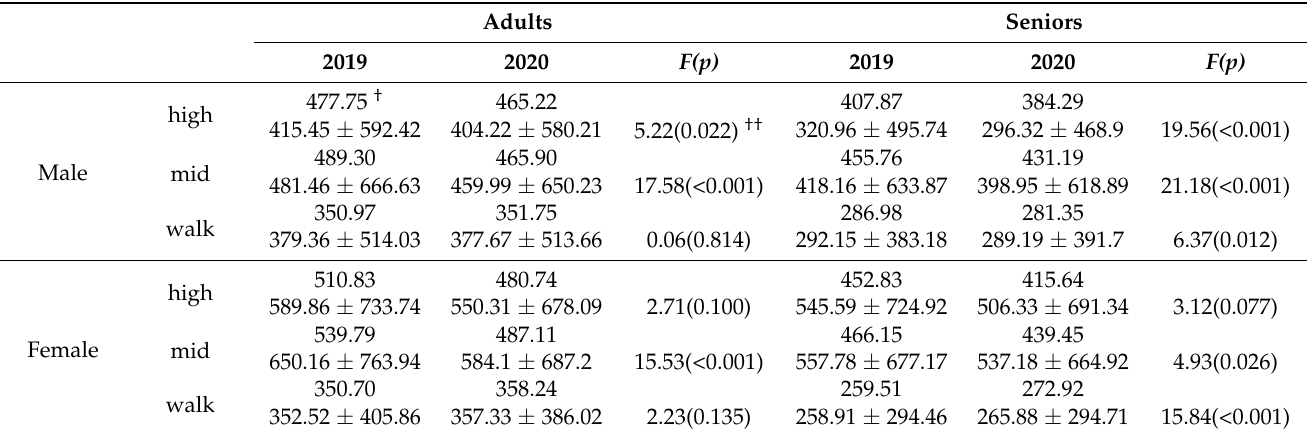
Table 5. Differences in physical activity (minutes spent weekly on physical activity) before and after COVID-19